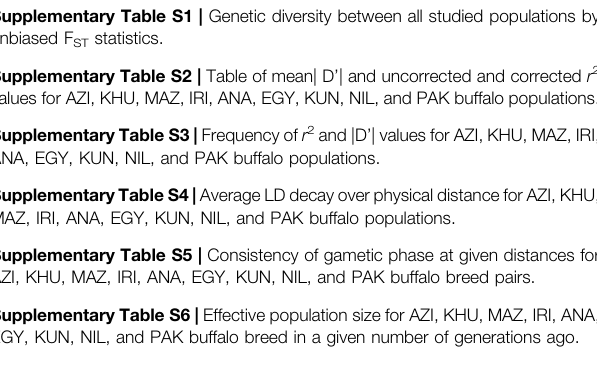
Supplementary Table S1 | Genetic diversity between all studied populations by unbiased F ST statistics. Supplementary Table S2 | Table of mean| D ’ | and uncorrected and corrected r 2 values for AZI, KHU, MAZ, IRI, ANA, EGY, KUN, NIL, and PAK buffalo populations. Supplementary Table S3 | Frequency of r 2 and |D ’ | values for AZI, KHU, MAZ, IRI, ANA, EGY, KUN, NIL, and PAK buffalo